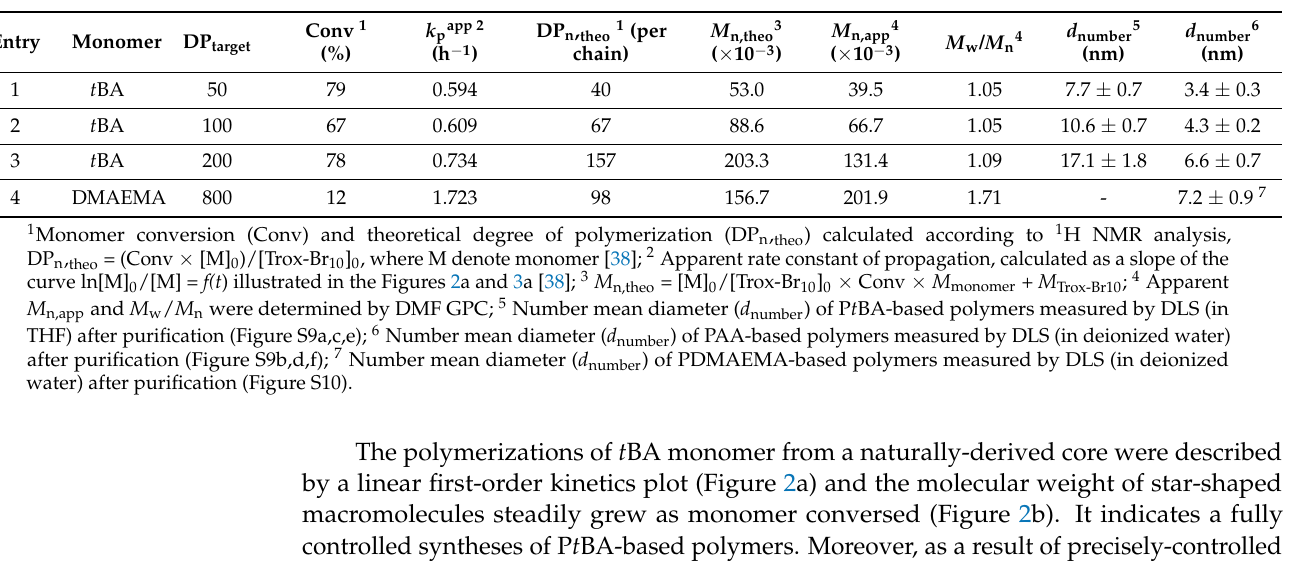
Table 1. Synthesis of star-shaped macromolecules composed of troxerutin core and P t BA or PDMAEMA side chains via the SARA ATRP